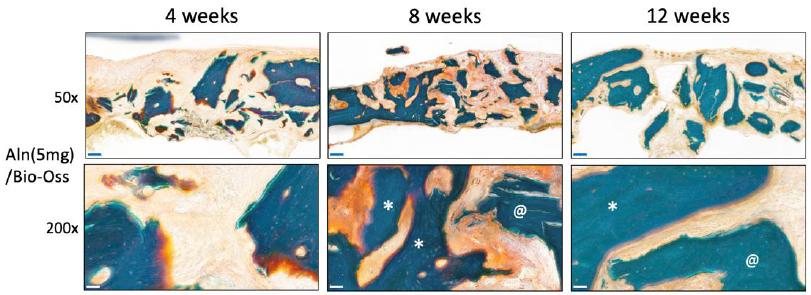
Figure 8. Representative sections of Masson–Goldner stains of 4, 8, and 12 weeks after implantation (50 × magnification, 200 µ m scale bar). Abundant surrounding fibrous tissue formation and woven bone formation were visible in the most of both samples, especially at 8- and 12-week point. Similar findings were observed on high magnification field (200 × magnification, 50 µ m scale bar). Blood vessels (arrowhead). InRoad bone graft (#). Bio-Oss bone graft (@). New bone formation (*).